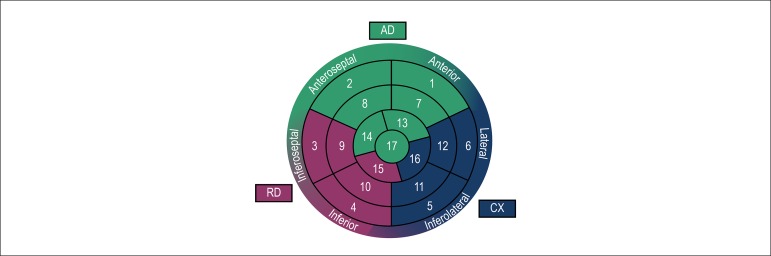
Polar map with coronary irrigation correlation. AD: anterior descending
coronary artery; CX: circumflex coronary artery; RD: right coronary
artery.